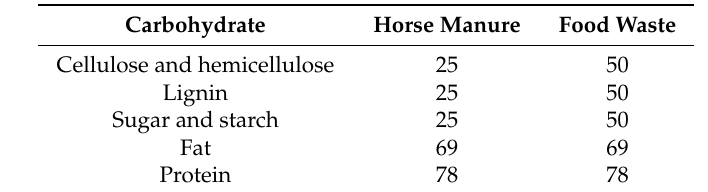
Table A6. Share of methane from carbohydrates in raw gas from anaerobic digestion (%). Benchmarking with default values for food waste, adjustment made in the validation process to meet reasonable gas production as found in literature.